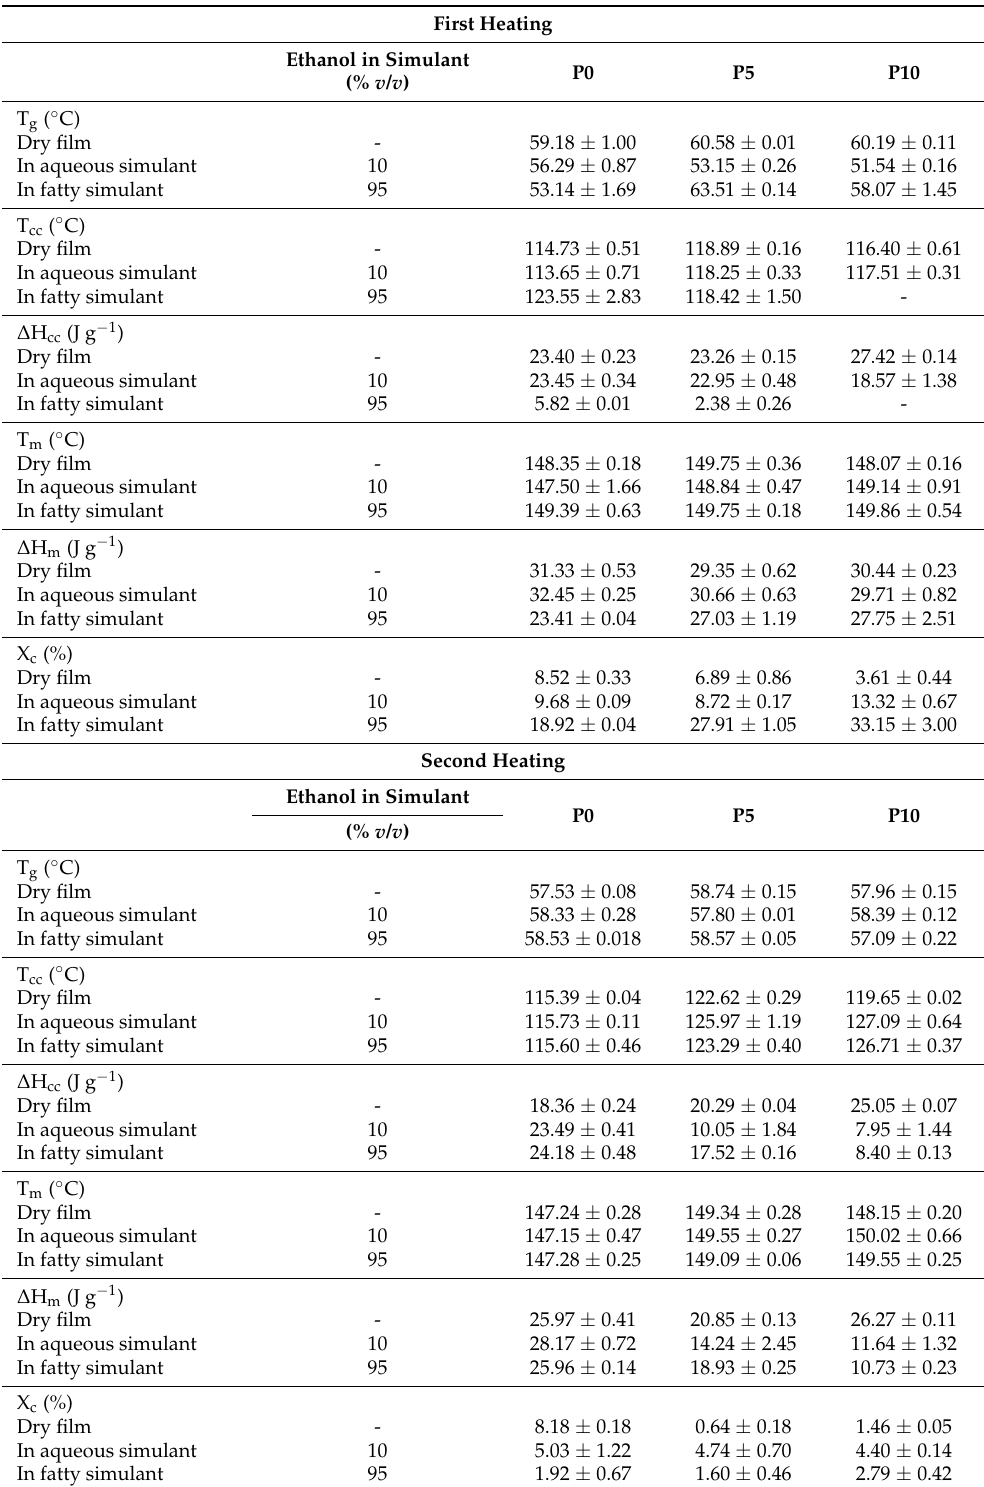
Table A2. Results of DSC analysis of poly(lactic acid) (P0) and active films (P5 and P10) before and after immersion in food simulants at 25 ◦ C for 48